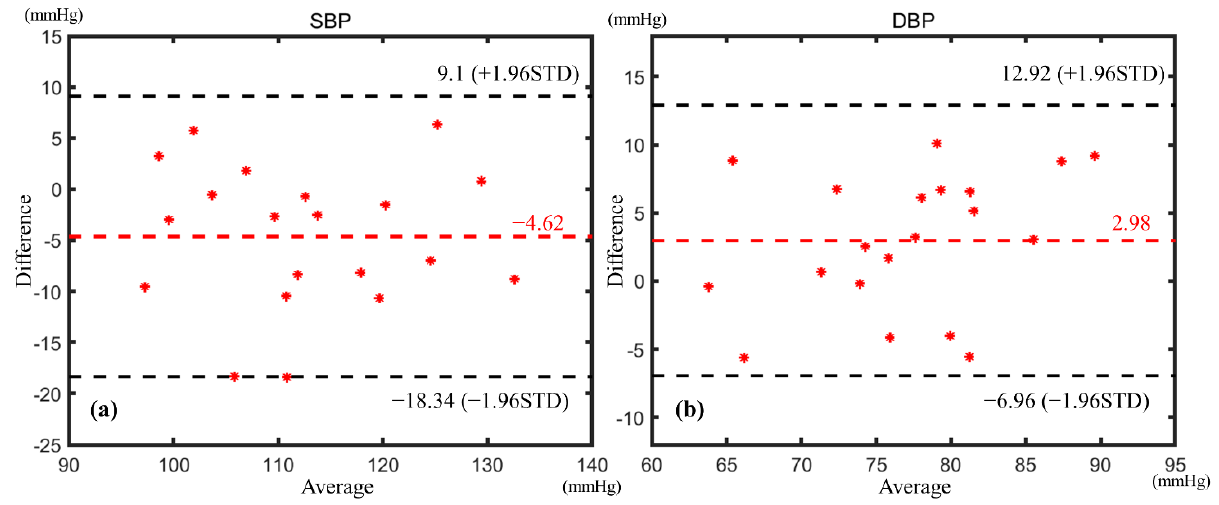
Figure 10. Initial BP caalibration results for the 20 subjects.